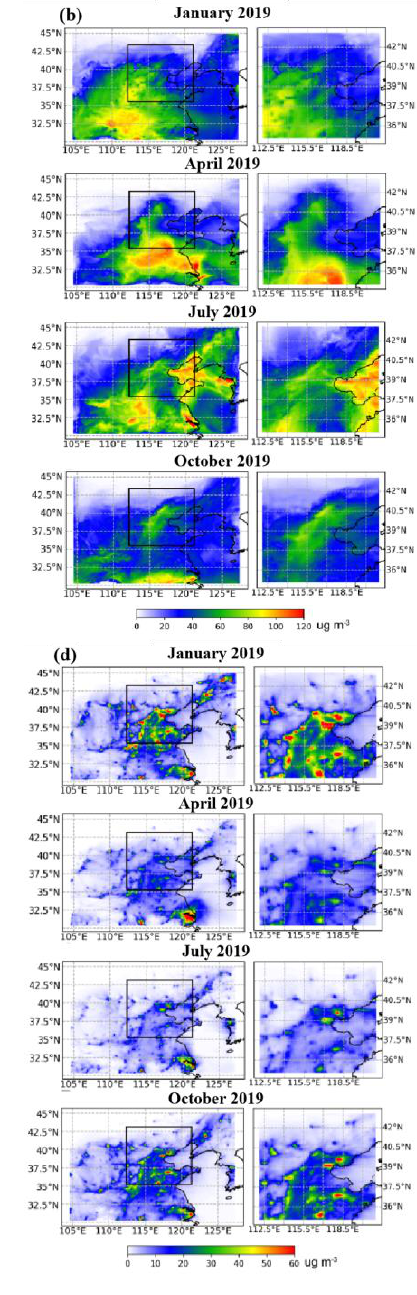
Figure 4. Spatial distribution of surface ( a ) PM 2.5, ( b ) MDA8 O 3 , ( c ) SO 2 , and ( d ) NO 2 concentrations over the NCP in four seasons of 2019.